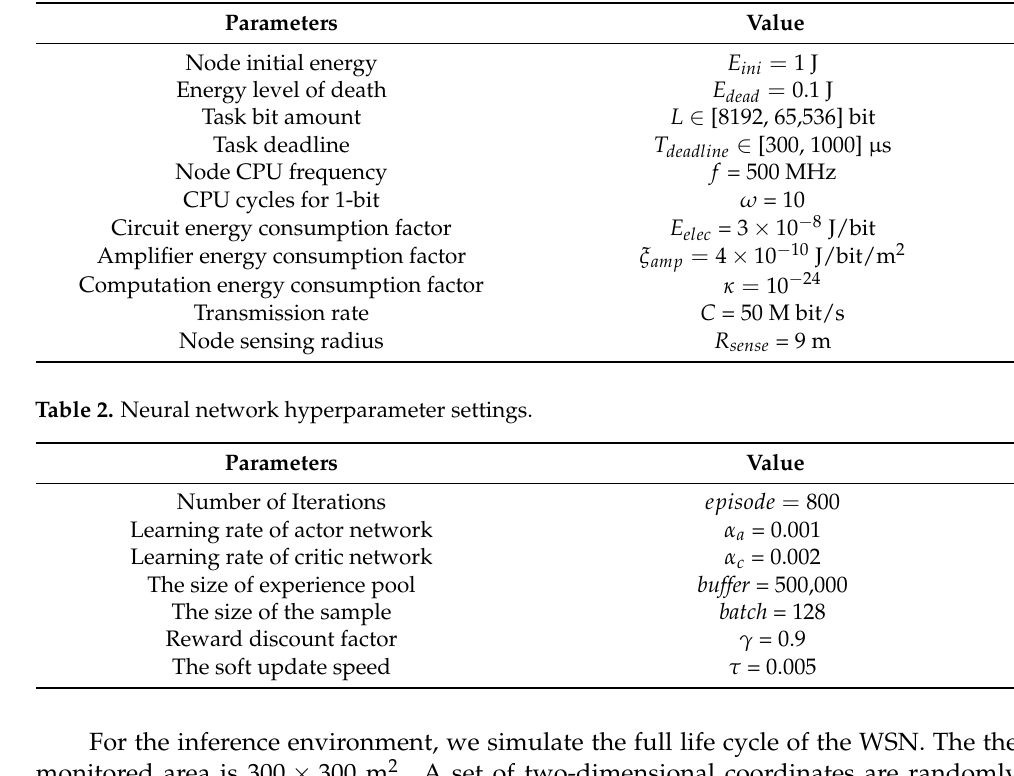
Table 1. Environment parameter settings.